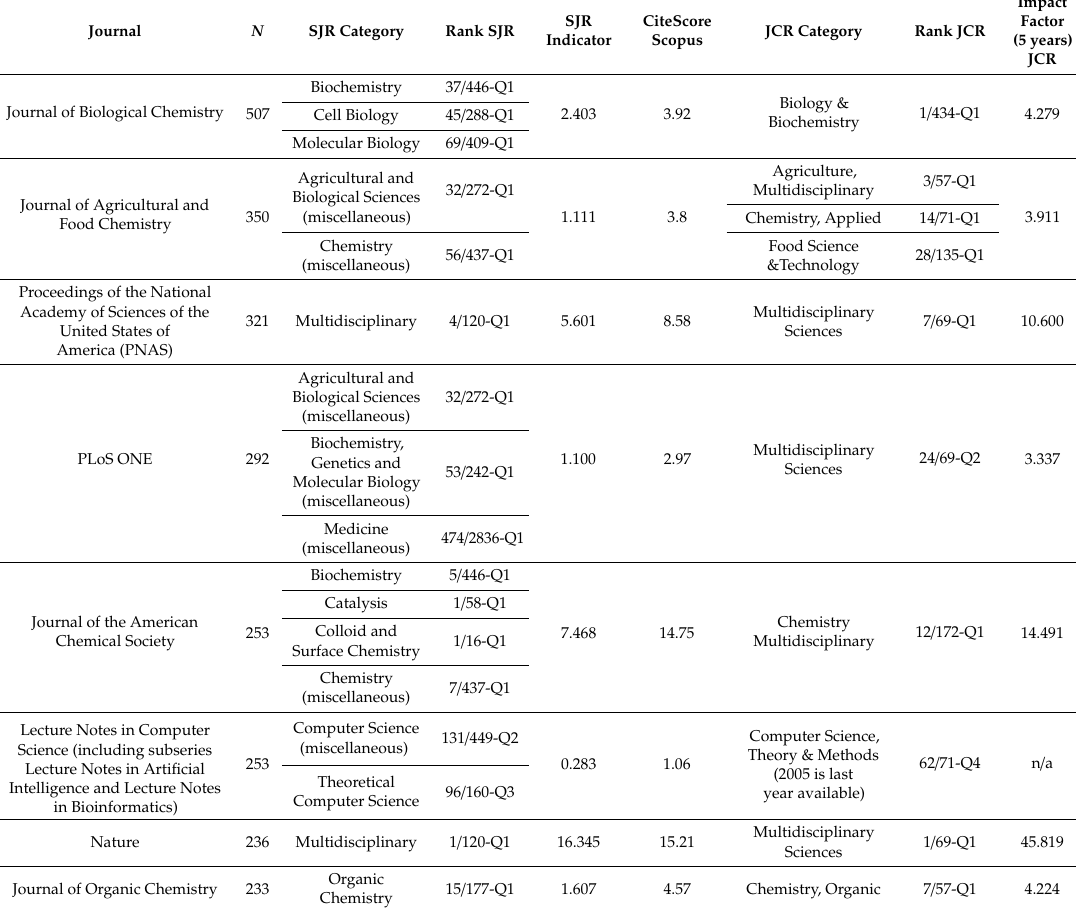
Table 3. Top 20 Journals and their metrics (Data